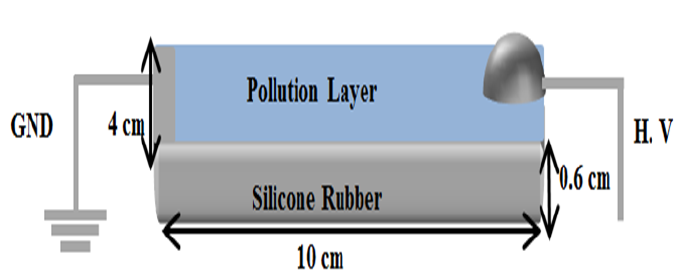
Figure 2. Test sample